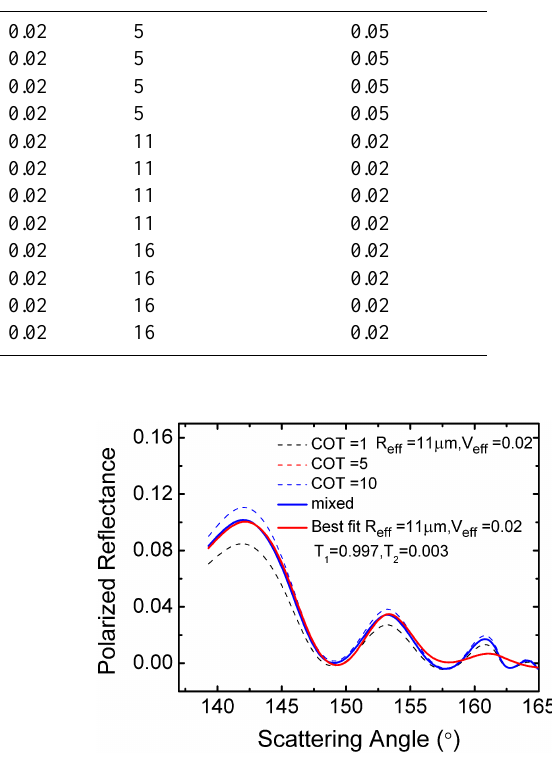
Figure 3. The retrievals from a heterogeneous cloud field with con- stant CDR = 11µm and EV = 0.02 and three equal-area parts with COT = 1, 5, and 10. The black, blue, and red dashed lines indicate the separate rainbow structure for sub-grid-scale cloud fields with COT = 1, 5, and 10, respectively; the blue line is the rainbow struc- ture for the heterogeneous cloud field; the red line represents the best